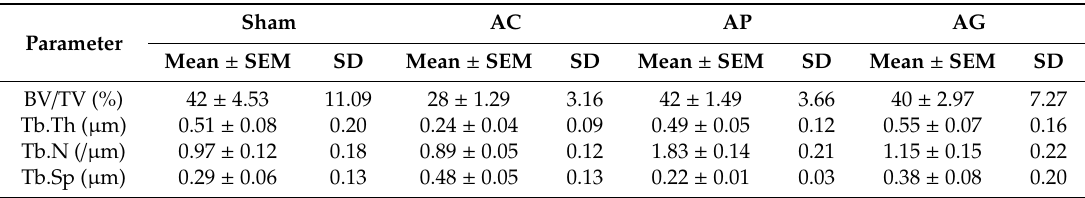
Table 1. Mean values, standard error of mean (SEM), and standard deviation (SD) of structural histomorphometric parameters.